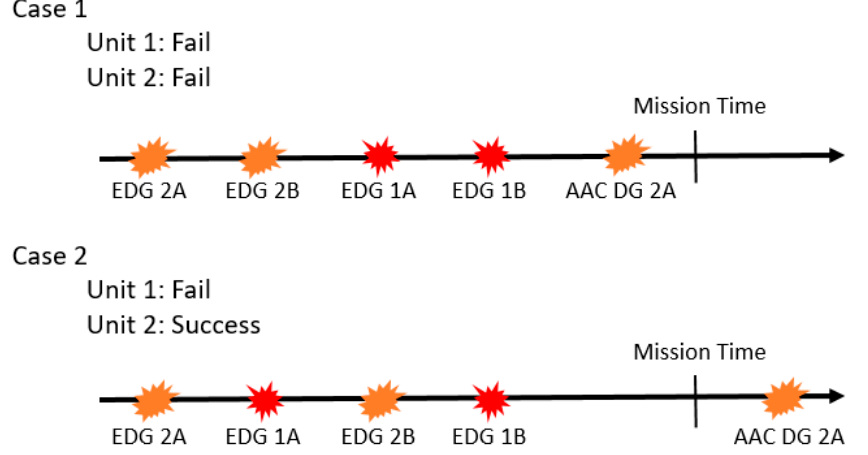
Figure 11. Cutsets that change the success or failure of Unit 2 depending on the failure time of the AAC DG.